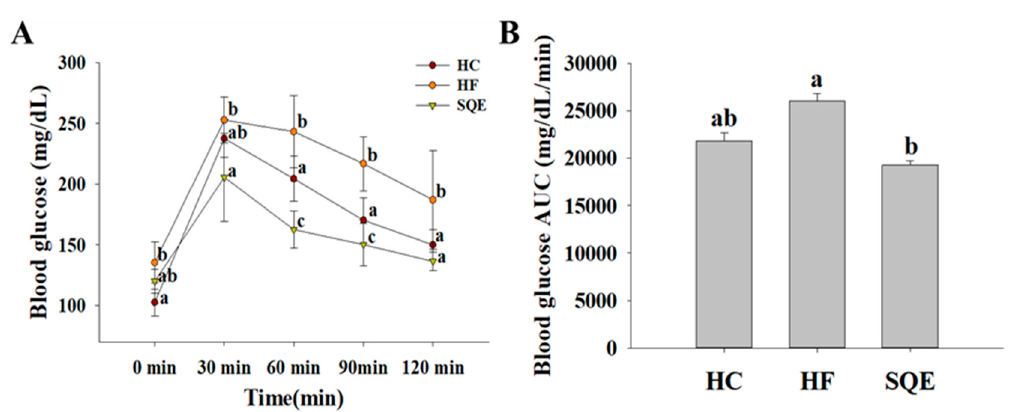
Figure 3. Effect of SQE supplementation on glucose tolerance by OGTT in HF-diet-fed rats: ( A ) Oral glucose tolerance test (OGTT); ( B ) the area under the curve (AUC). Data are given as mean ± SD ( n = 7). Different letters in each assay indicate significant differences among the HC, HF, and SQE groups by Tukey’s multiple range test ( p < 0.05). HC, 46% carbohydrate diet; HF, 60% fructose diet; SQE, 60% fructose diet with SQE (500 mg/kg of BW) in drinking water. BW, body weight; HC, high-carbohydrate-diet-fed rats; HF, high-fructose-diet-fed rats; SQE, the high-fructose-diet-fed rats supplemented with S. quelpaertensis leaf extract.